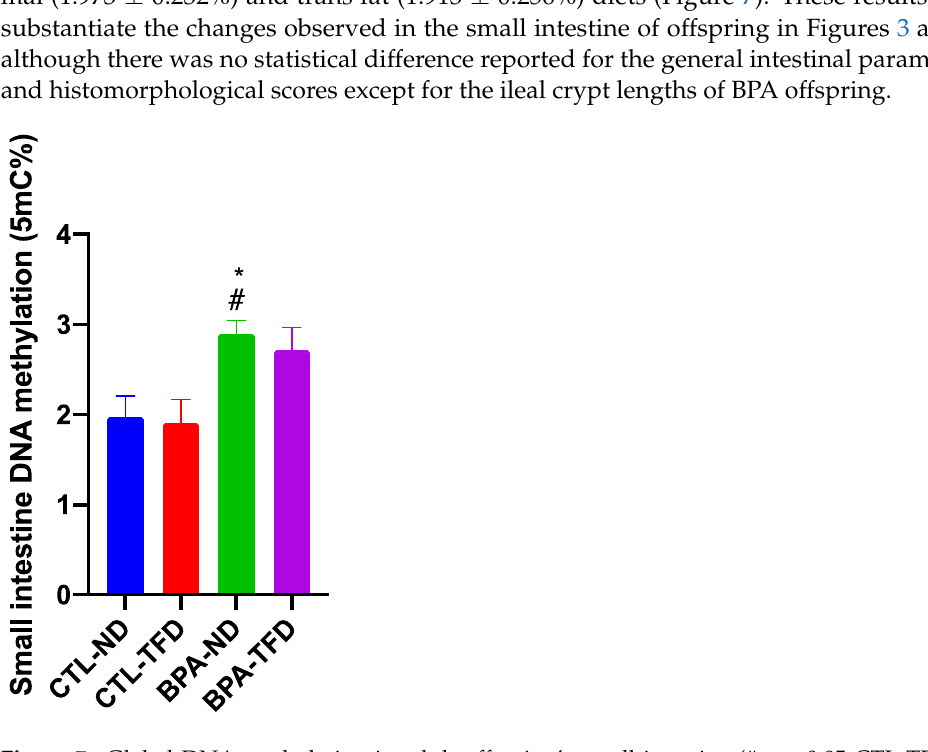
Figure 7. Global DNA methylation in adult offspring’s small intestine (# p < 0.05 CTL-TFD vs. BPA-ND, * p < 0.05 BPA-ND vs. CTL-ND; n = 5